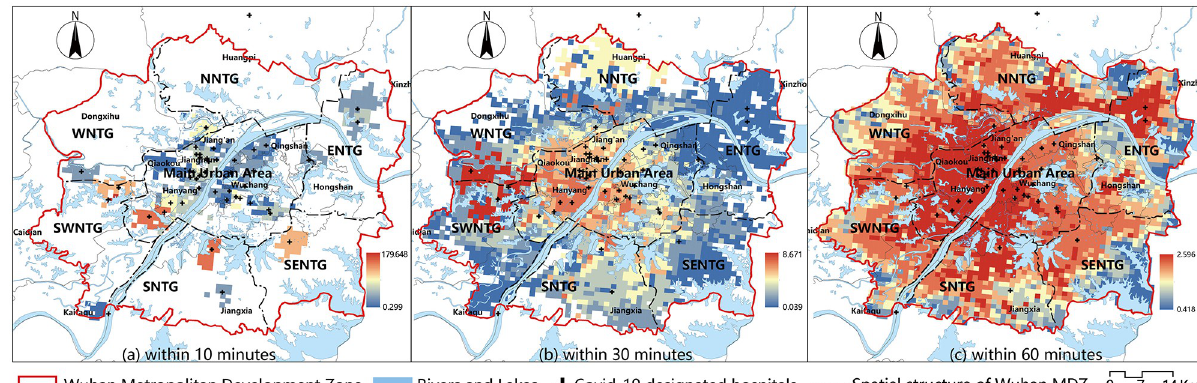
Fig 6. Accessibility of designated hospitals. (a)Within 10 minutes, (b) Within 30 minutes, (c) Within 60 minutes.